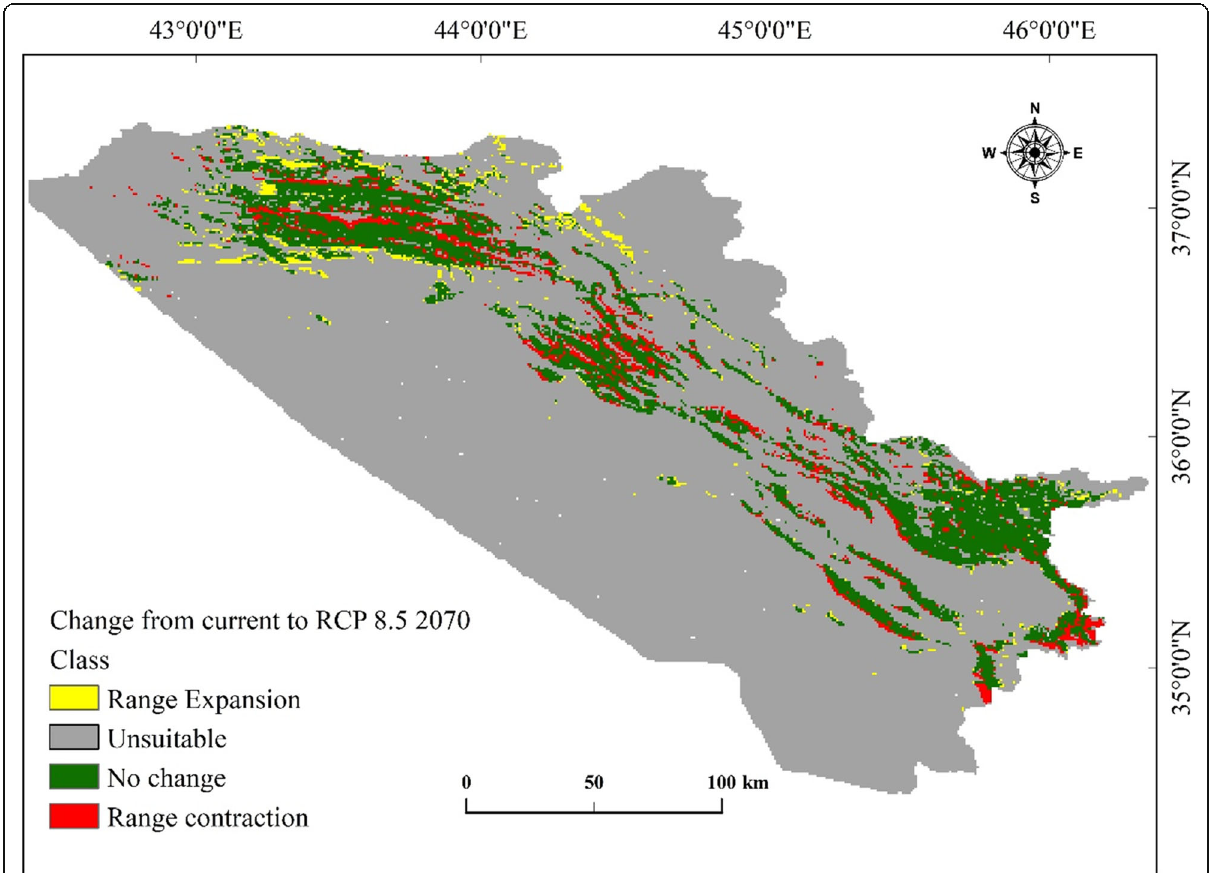
Fig. 6 Difference between the current distribution and future distribution under the RCP 8.5 2070 climate change